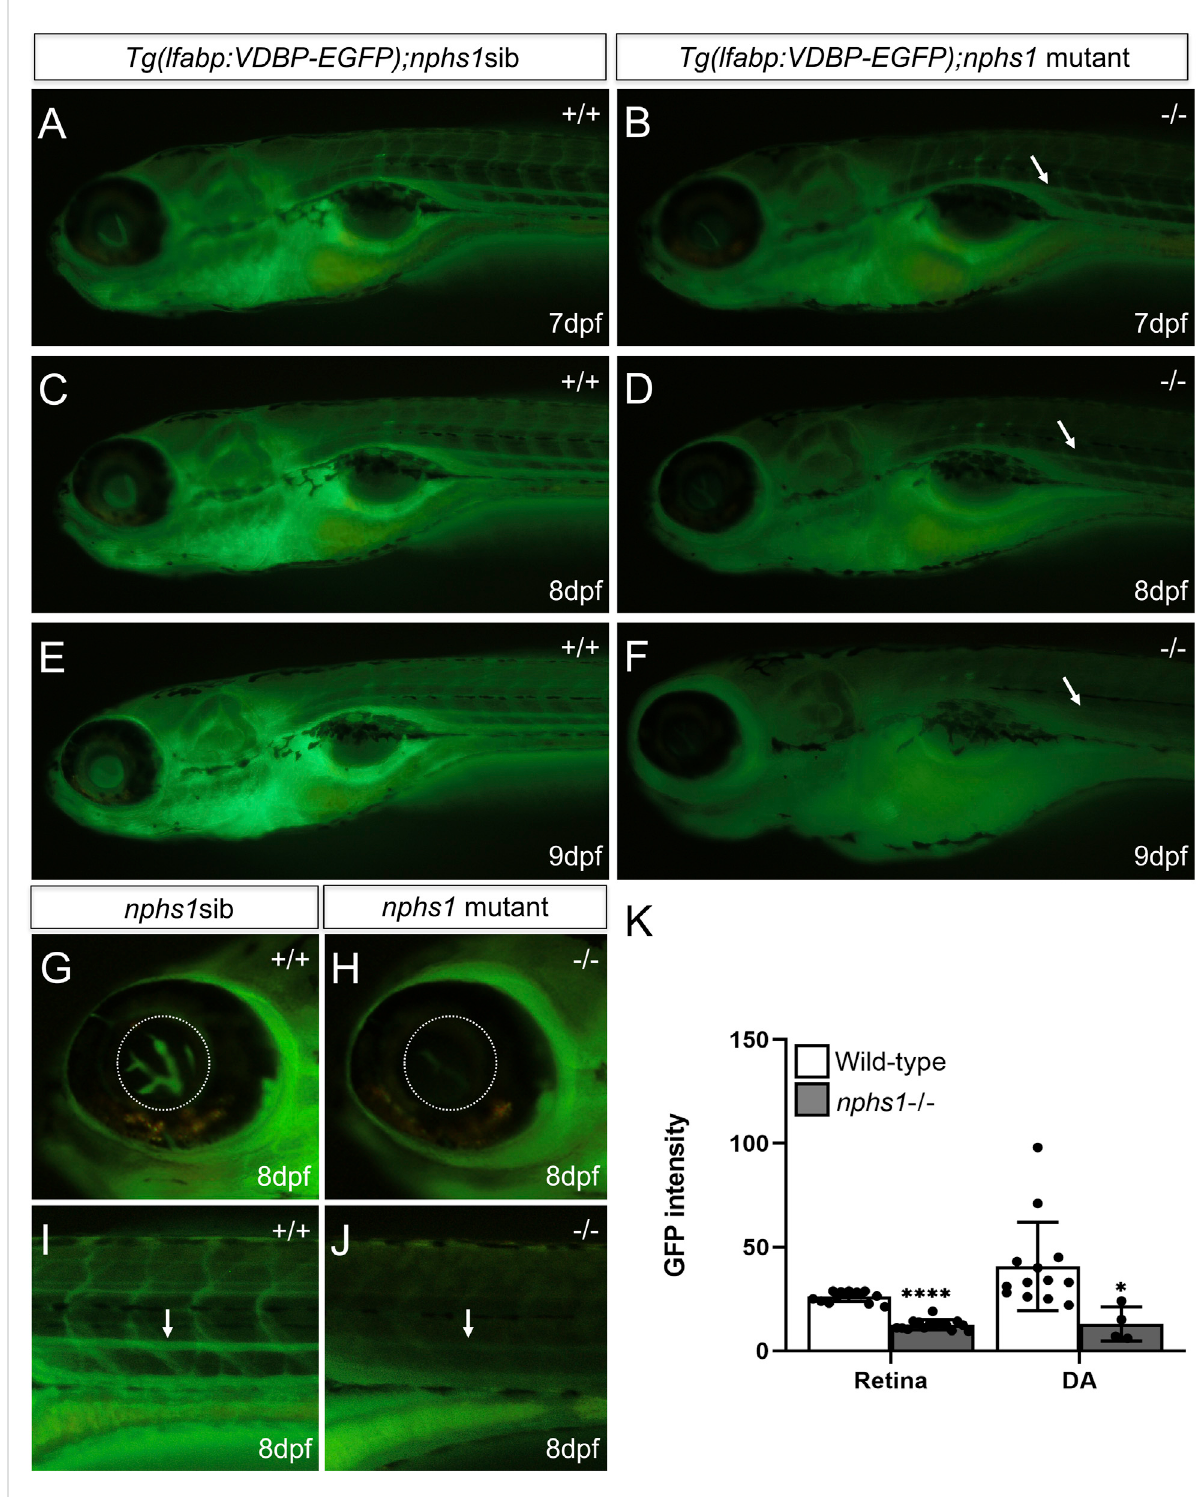
Measurement of hypoalbuminemia-like phenotype in nphs1-/- zebra fi sh. (A,C,E) The GFP fl uorescence in wild-type siblings with Tg (l-fabp: VDBP-EGFP) at 7-9 dpf. (B,D,F) The GFP fl uorescence in nphs1-/- mutants with Tg (l-fabp:VDBP-EGFP) at 7-9 dpf. (G – J) The GFP fl uorescence in retina vessels and dorsal aorta of wild type fi sh (G,I) and of nphs1-/- mutants (H,J) at 8 dpf. (K) The quantitative measurements of the GFP fl uorescence intensity in the retinal vessels (G,H) and the dorsal aorta (I – J) (arrow) using ImageJ. The error bars show the standard error of the mean (SEM) (* p ≤ 0. 1, **** p ≤ 0. 0001) (Student ’ s